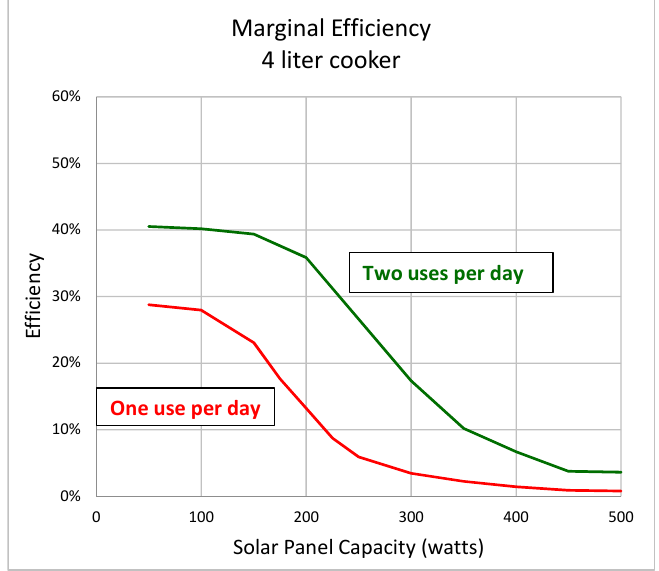
Figure 5. Marginal efficiency vs. solar panel capacity for a DDS cooker and water heater for two different use case. In the more efficient use case, water is drawn from the cooker twice per day at noon and 5 p.m., and in the less efficient use case, water is drawn once per day at 4 p.m.